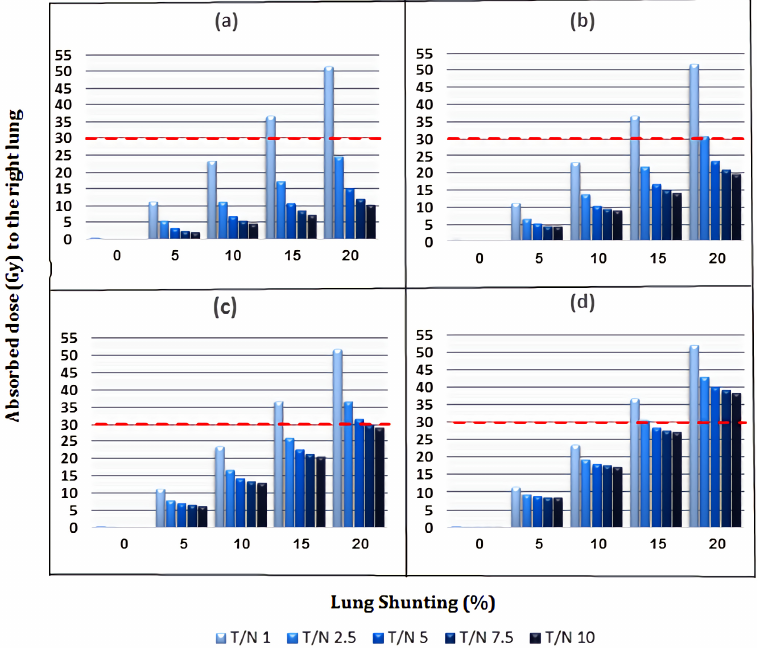
Figure 8. Absorbed dose to the right lung for various TIs of ( a ) 10, ( b ) 30, ( c ) 50, and ( d ) 70%, LS, and T/N, when 120 Gy is delivered to the tumour. The red dotted lines indicate the maximum dose limit to lungs of 30 Gy.